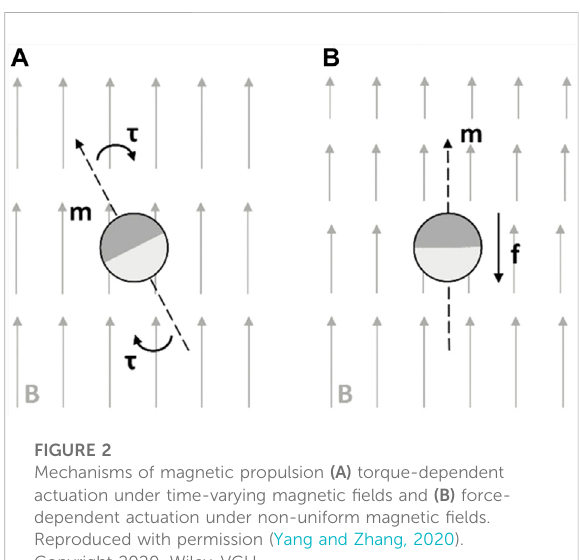
FIGURE 2 Mechanisms of magnetic propulsion (A) torque-dependent actuation under time-varying magnetic fi elds and (B) force- dependent actuation under non-uniform magnetic fi elds. Reproduced with permission (Yang and Zhang, 2020). Copyright 2020,